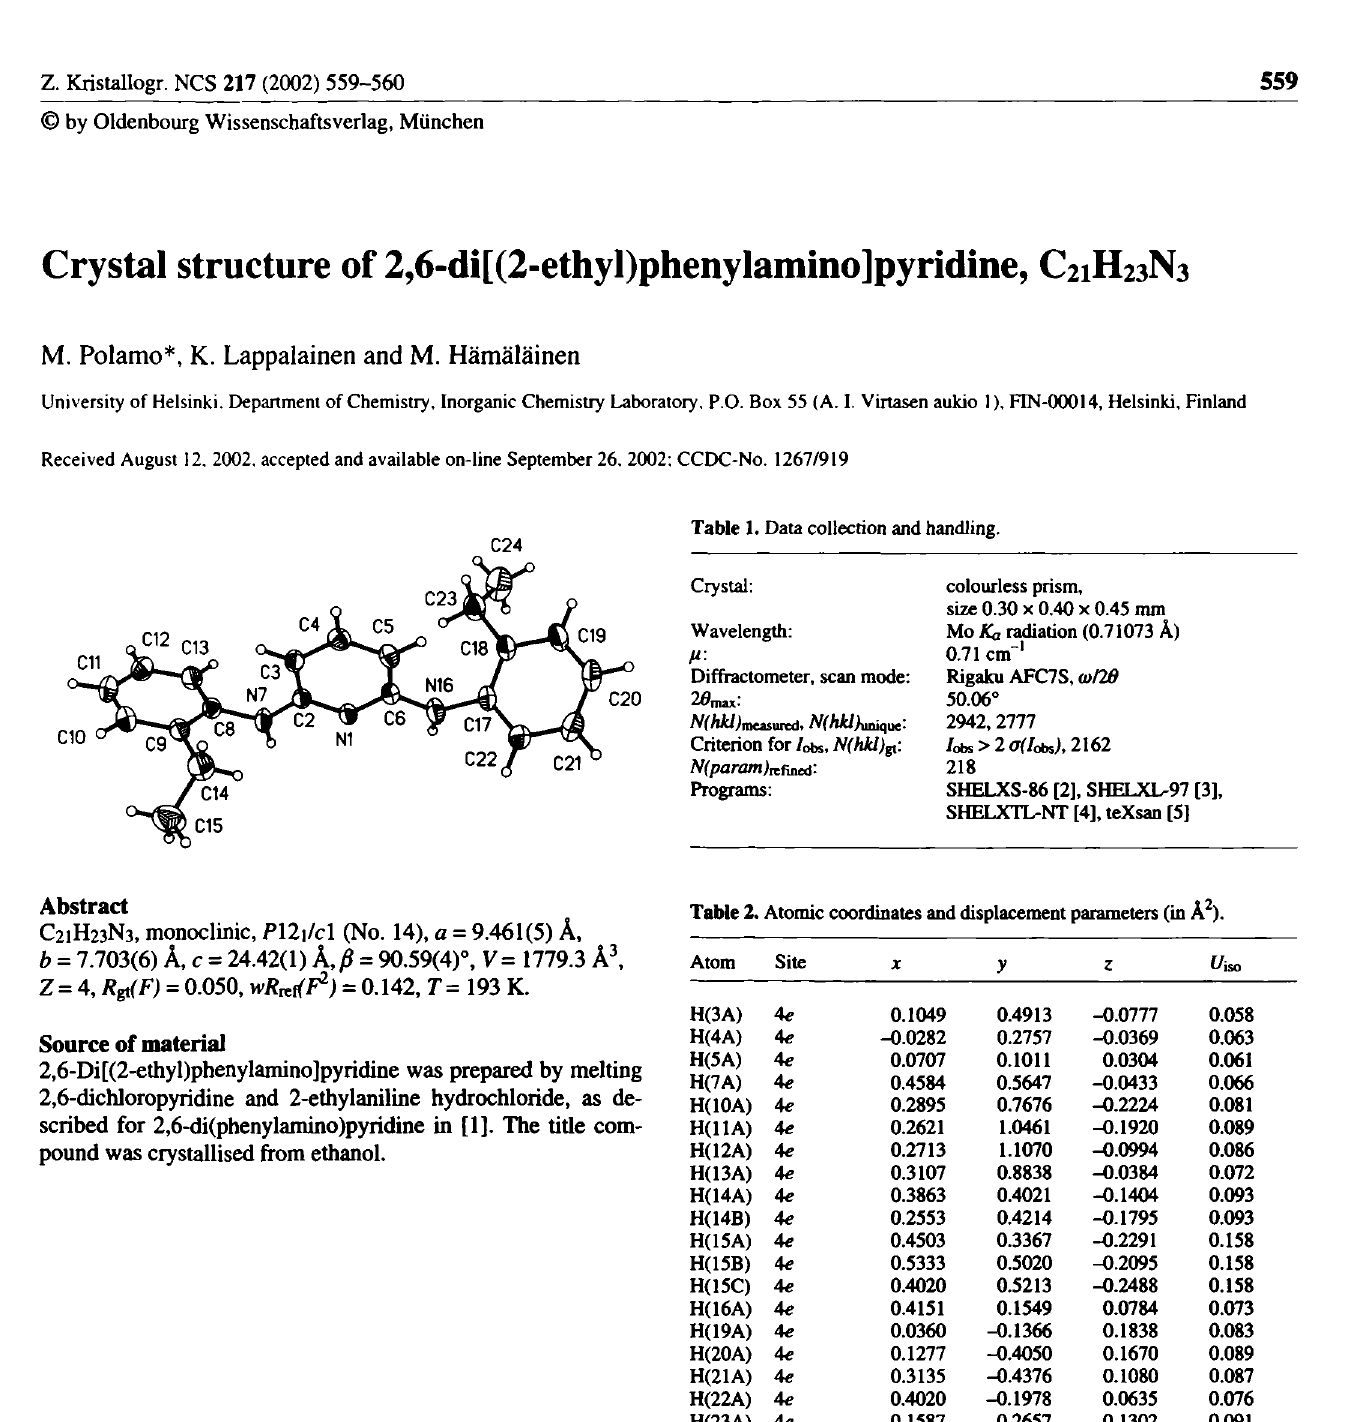
Table 3. Atomic coordinates and displacement parameters (in Â 2